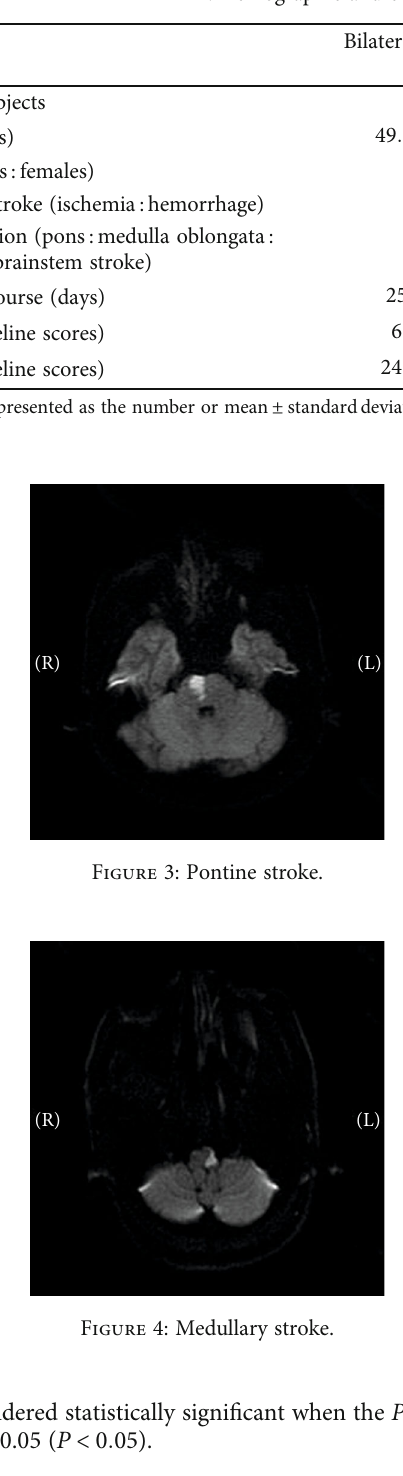
Table 1: Demographic and clinical characteristics of patients in the three study